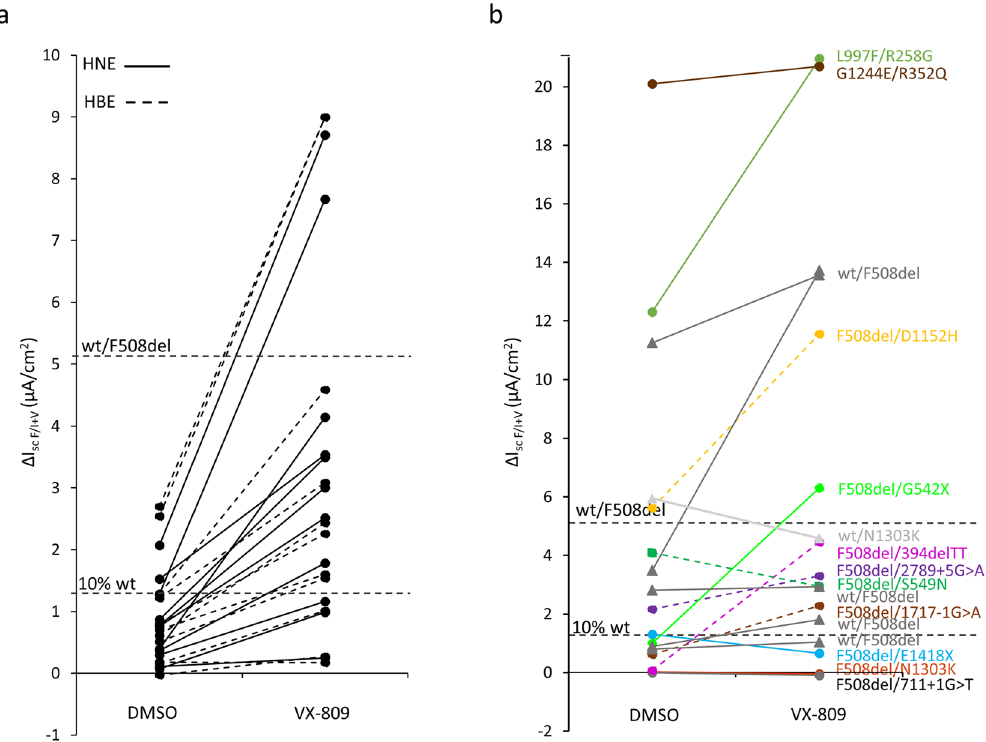
Figure 4. Lumacaftor stimulated correction of CFTR-dependent Cl − secretion. I sc response to Forskolin (10 µ M)/IBMX (100 µ M) + VX-770 (10 µ M) ( ∆ I scF/I + V ) after treatment for 48 h at 37 °C with DMSO or lumacaftor 3 µ M of HNE (solid line) and HBE (dashed line) cell cultures from different F508del/F508del patients ( a ) and patients with other genotypes ( b ). Specific genotypes are indicated and color coded. Each pair of points corresponds to an individual patient. Supplemental horizontal dashed lines in the graphs indicate the level of mean ∆ I scF/I + V in wt/F508del cultures sampled from healthy carriers and 10% of the mean ∆ I scF/I + V value in wt/wt cultures corresponding to the level of CFTR activity observed in patients with mild CF